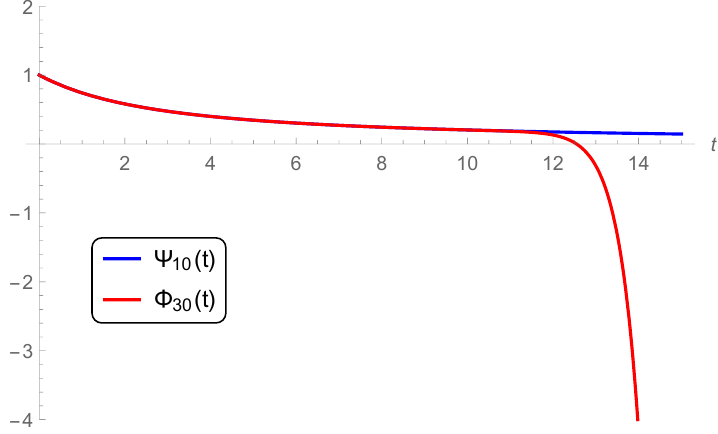
Figure 2. Comparison between Ψ 10 (present) and Φ 30 (Ref. [9]) at λ = 1, q = 1.5, and α = 1 (ordinary